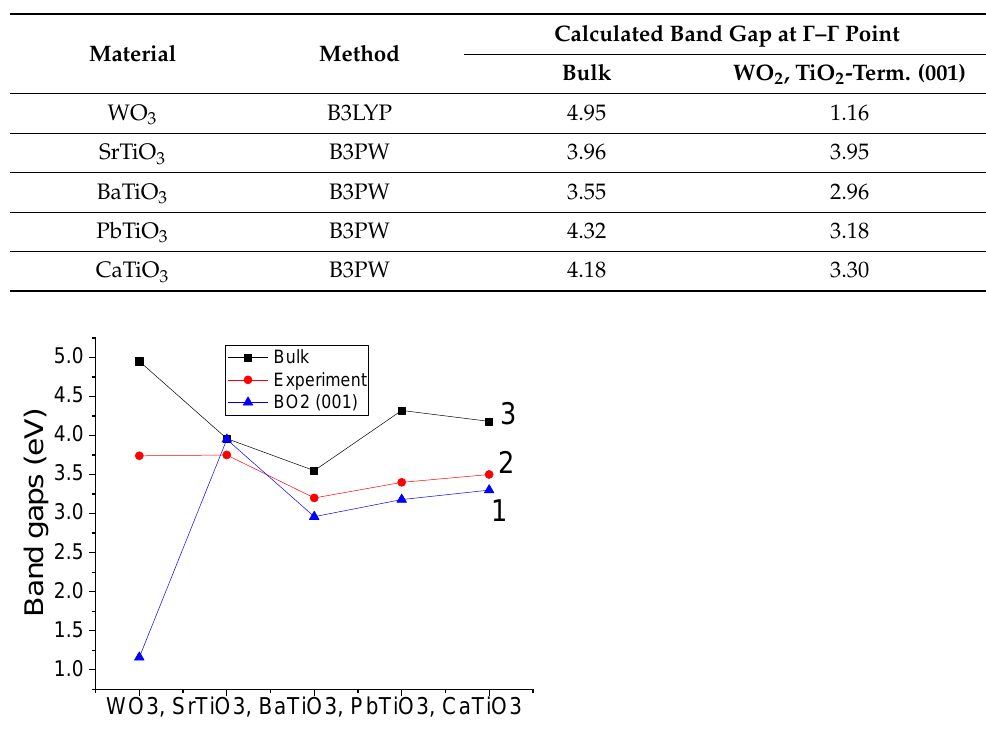
For the first principles-calculated WO 2- or TiO 2 -terminated WO 3 , SrTiO 3 , BaTiO 3 , PbTiO 3 and CaTiO 3 (001) surfaces, as a rule, all first-layer surface atoms relax inwards, whereas all second-layer surface atoms relax upwards. The only two exceptions from this systematic trend are the upward relaxation of WO 2- or TiO 2 -terminated WO 3 and PbTiO 3 (001) surface first-layer O atoms. As a result of our ab initio-calculated atomic relaxation, TiO 2 -terminated SrTiO 3 , BaTiO 3 , PbTiO 3 and CaTiO 3 (001) surfaces exhibited a reduction of the interlayer distance Δ d 12 (−5.80, −5.59, −8.13, −4.46% of a 0 , respectively) as well as an expansion of Δ d 23 (+3.55, +2.51, +5.32, +2.75% of a 0 , respectively). It is worth noting that after geometry optimization, it is very useful to perform ab initio molecular dynamics computations to ensure the stability of the structures over time [77]. The changes in the interlayer distances between the first and second layer (Δ d 12 ) were always larger than between the second and third layer (Δ d 23 ) for all our calculated perov- skites SrTiO 3 , BaTiO 3 , PbTiO 3 and CaTiO 3 . The Ti–O chemical bond population in SrTiO 3 , BaTiO 3 , PbTiO 3 and CaTiO 3 bulk was always smaller than near their TiO 2 -terminated (001) surface (see Figure 4). In contrast, the W–O chemical bond population in the WO 3 bulk (0.142 e ) was larger than near the WO 2 -terminated WO3 (001) surface (0.108 e ). Nevertheless, the largest W–O chemical bond population, according to our ab initio calculations, is between the W atom located on the WO 2 -terminated WO 3 (001) surface and the second-layer O atom (0.278 e ). It was worth noting, that also for the related material ReO 3 , according to our calculations [76], the situ- ation was similar. Namely, the Re–O chemical bond population in the ReO 3 bulk (0.212 e ) was larger than near the ReO 2 -terminated ReO 3 (001) surface (0.170 e ). Nevertheless, the Re–O chemical bond population between the Re atom located on the ReO 2 -terminated ReO 3 (001) surface upper-layer and O atom located on the ReO 2 -terminated ReO 3 (001) surface second layer was the largest (0.262 e ). According to our B3LYP or B3PW calculations, the WO 3 , SrTiO 3 , BaTiO 3 , PbTiO 3 and CaTiO 3 bulk Γ–Γ band gap values (4.95, 3.96, 3.55, 4.32, 4.18 eV, respectively) were always reduced with respect to the bulk near the WO 2- or TiO 2 -terminated WO 3 , SrTiO 3 , BaTiO 3 ,